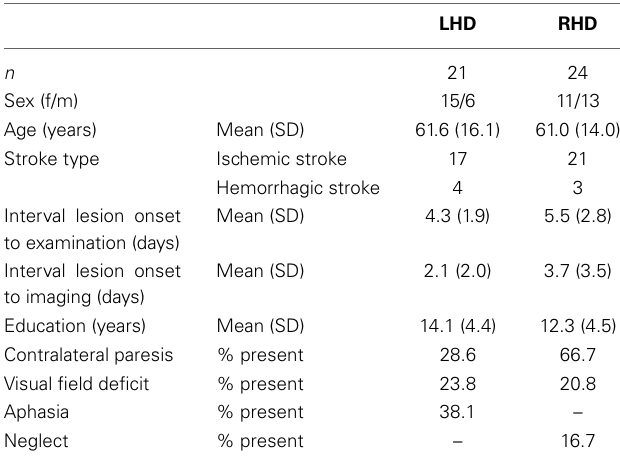
Table 1 | Demographic and clinical data of the left- and right- hemisphere damaged